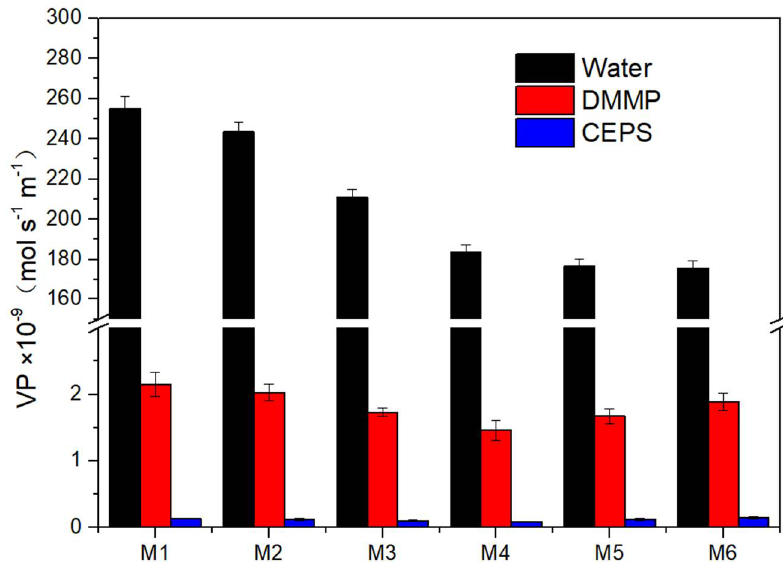
Figure 10. Vapor permeation of water, DMMP, and CEPS through M1–M6.